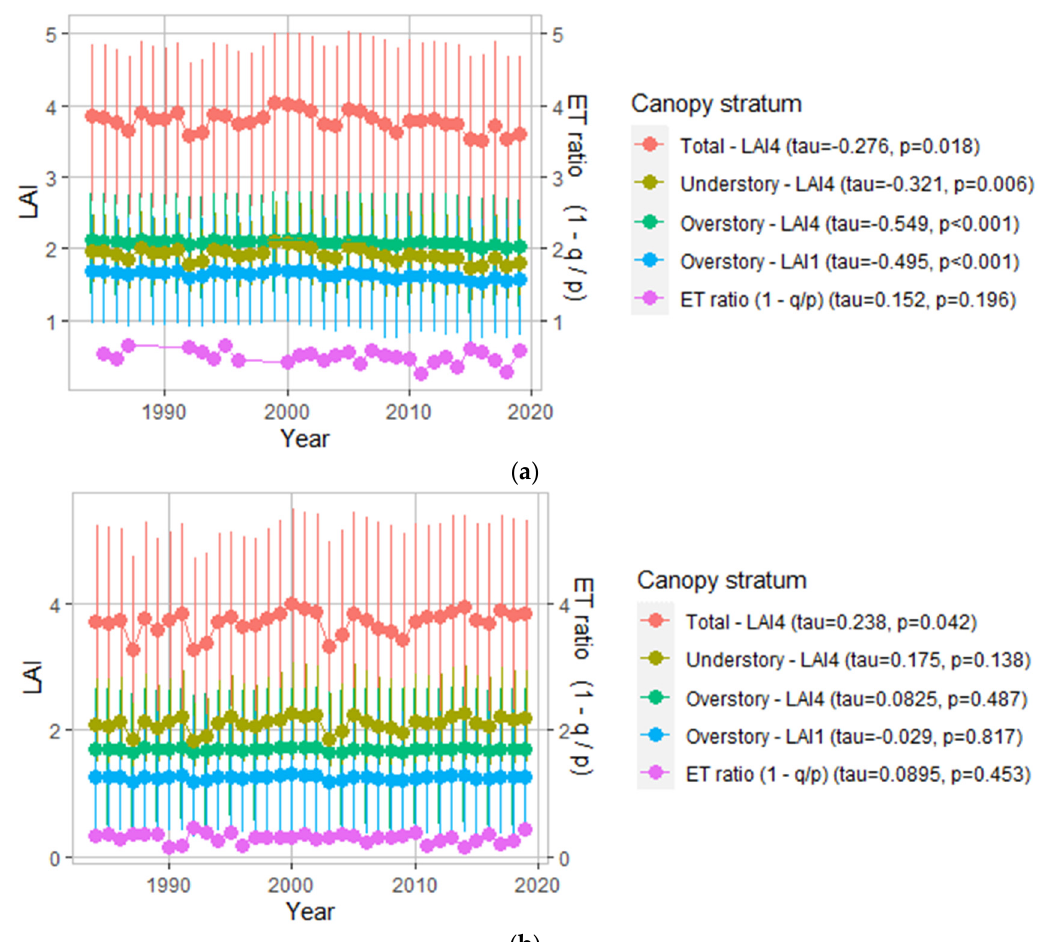
Figure 6. Annual time series of overstory, understory, and total leaf area index (LAI) in: ( a ) South Fork Flathead Watershed and ( b ) Middle Fork Flathead Watershed, for 1984–2019, as produced by random forests models based on methods LAI1 and LAI4, and ET ratio (1 – ratio of mean annual streamflow to mean annual precipitation). LAI points represent watershed-scale medians and bars represent the 1 st (lower) and 3 rd (upper) quartiles. Values of tau and associated p-values in the legend represent results of the Mann–Kendall trend test. Note missing observations for some years in the South Fork Flathead River due to lack of streamflow data.